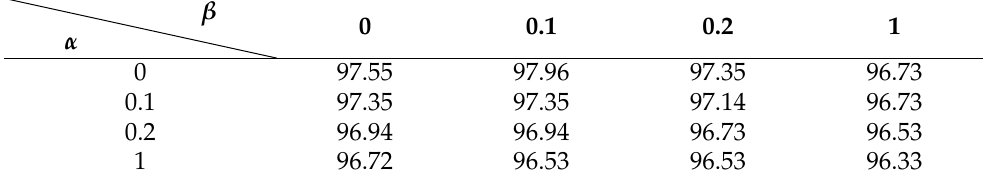
Table 4. Accuracy with different combinations of suppressing parameters α and β on dataset BT-4C.